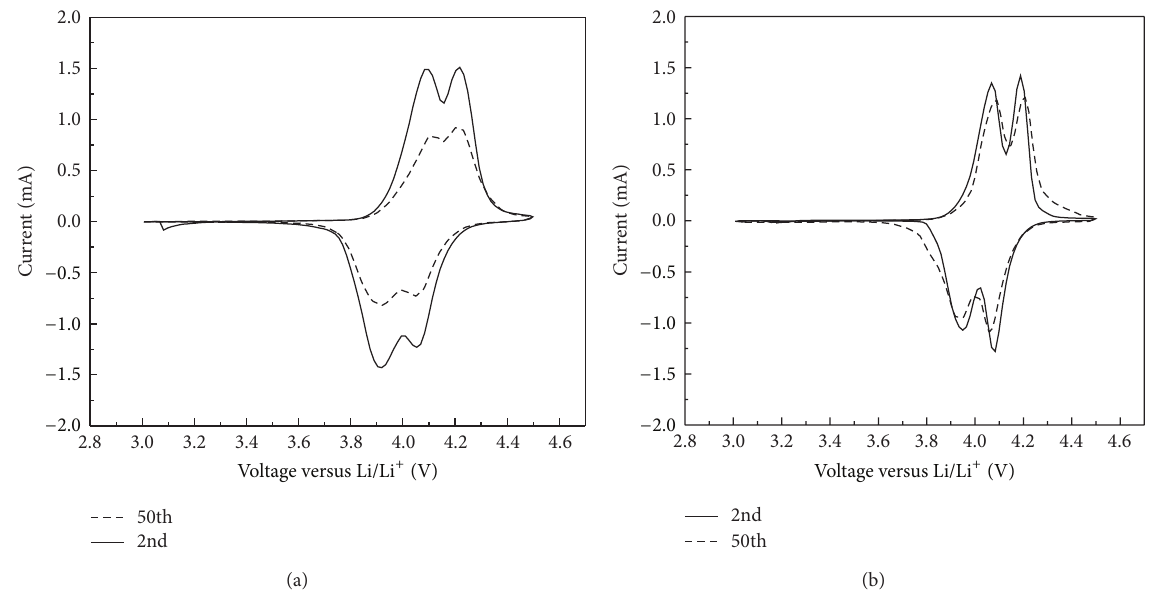
Figure 5: Cyclic voltammograms of cells containing (a) LiMn 2 O 4 and (b) Li 1.02 Mn 1.92 Al 0.02 Fe 0.02 Cr 0.02 O 3.92 F 0.08 after 2 and 50 cycles.